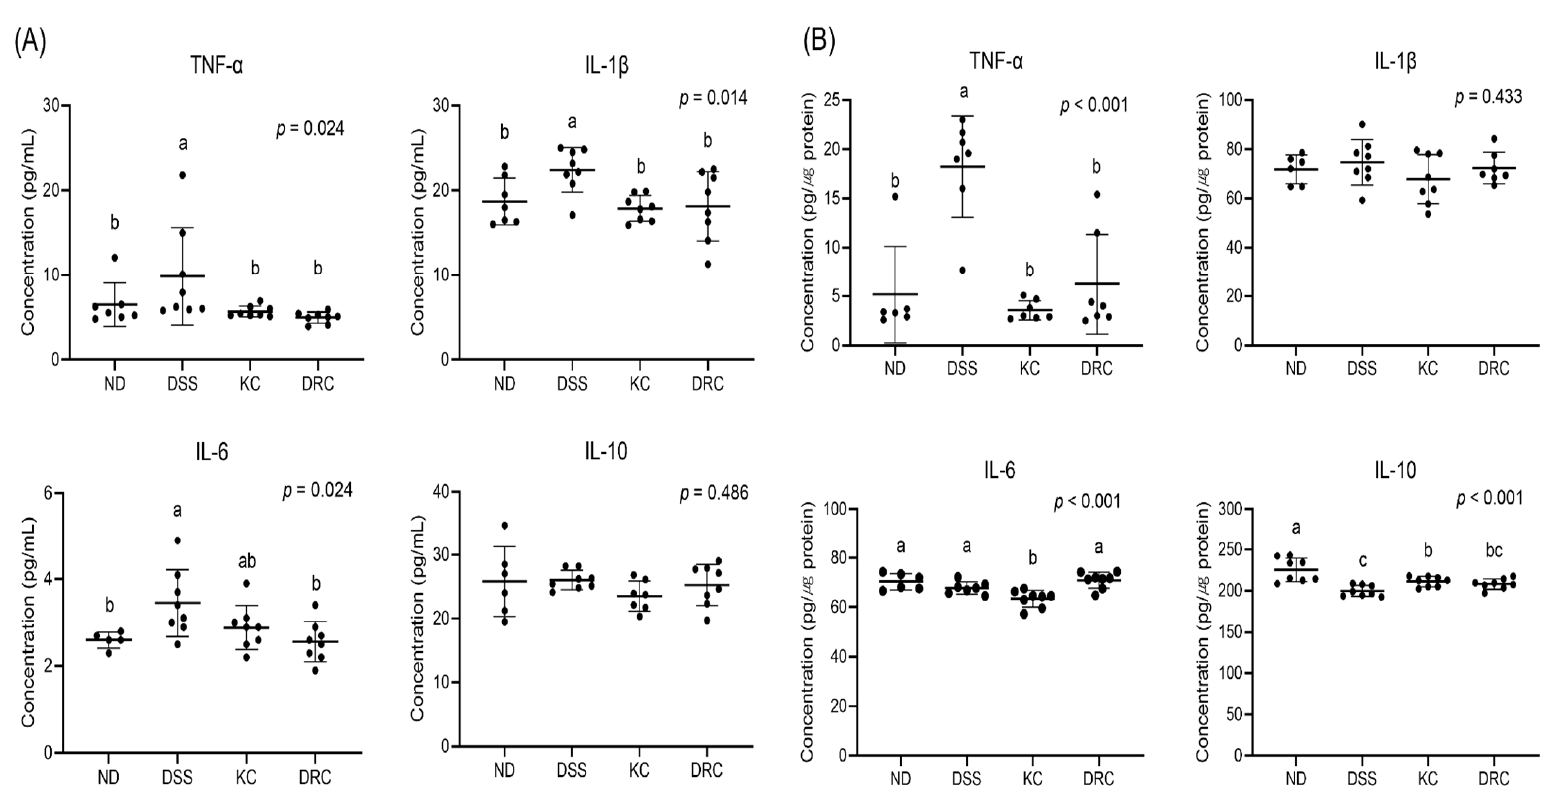
Figure 4. Effects of kimchi and Leu. mesenteroides DRC 1506 on pro-inflammatory and anti-inflammatory cytokines in serum ( A ) and colon tissue ( B ). Data values are expressed as scatter plots with median, minimum, and maximum values ( n = 5–8 per group). Comparisons among groups were evaluated using one-way ANOVA with Duncan’s post hoc test. Groups with different letters had a significant difference at p < 0.05. ND, normal group; DSS, DSS-treated group; KC, DSS + 1 × 10 9 CFU/day/mouse of kimchi group; DRC, DSS + 1 × 10 9 CFU/day/mouse of Leu. mesenteroides DRC 1506 isolated from